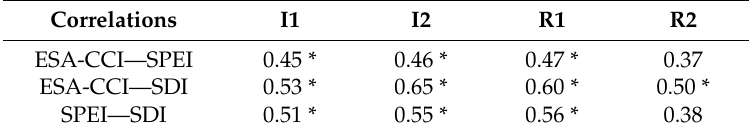
Table 1. Correlation analysis of soil moisture anomaly indicators for each cropping season